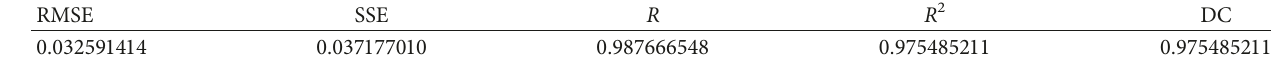
Table 5: Fitness determination parameters.